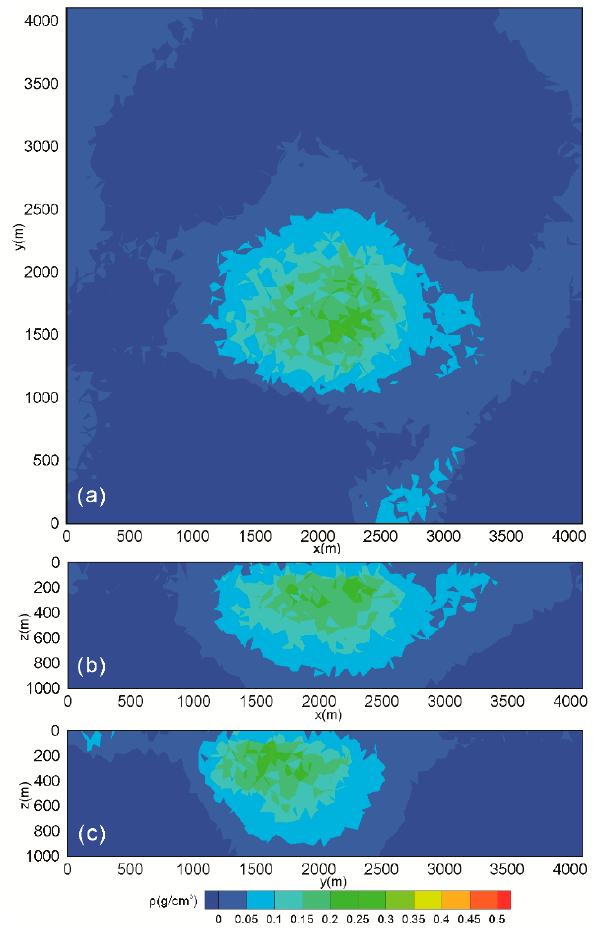
Figure 9. Smooth inversion result of Vinton Dome on ( a ) x-y-plane at z = 0.3 km; ( b ) x-z-plane at y = 1.7 km; ( c ) y-z-plane at x = 2.2 km.